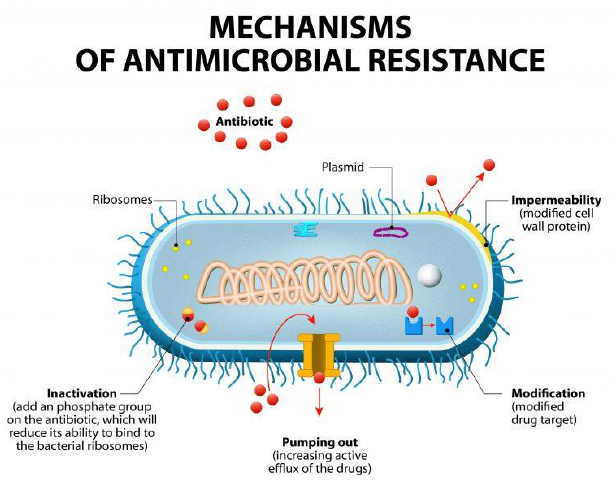
Figure 1. Mechanisms of bacterial resistance to antibiotics (from Designua/Shutterstock.com).